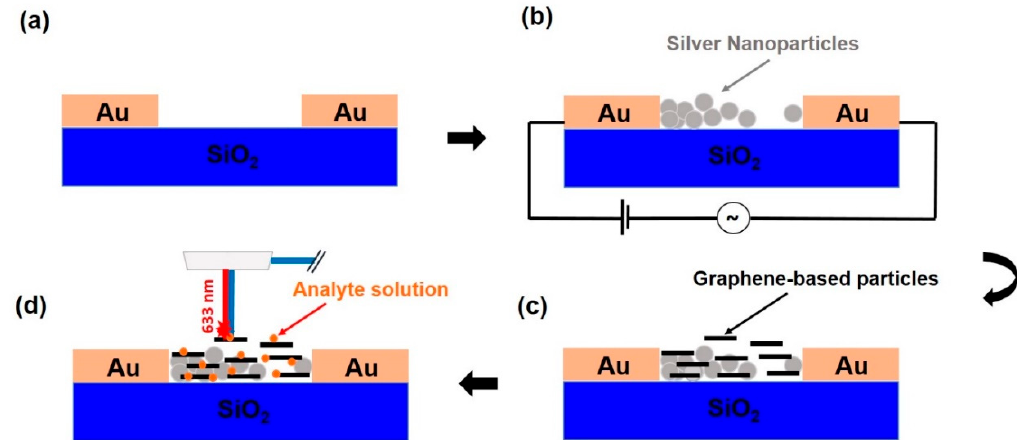
Figure 2. Schematic presentation of G-surface-enhanced Raman scattering (SERS) substrate preparation and detection process. ( a ) The individual electrode pairs are activated by an electric signal. ( b ) This procedure deposits silver nanoparticles into a SERS-active dendritic structure. ( c ) Deposition of a graphene-based coating on the SERS-active substrate through spray-coating. ( d ) Drop-casting of analyte (orange dots) onto the G-SERS substrate for Raman testing.